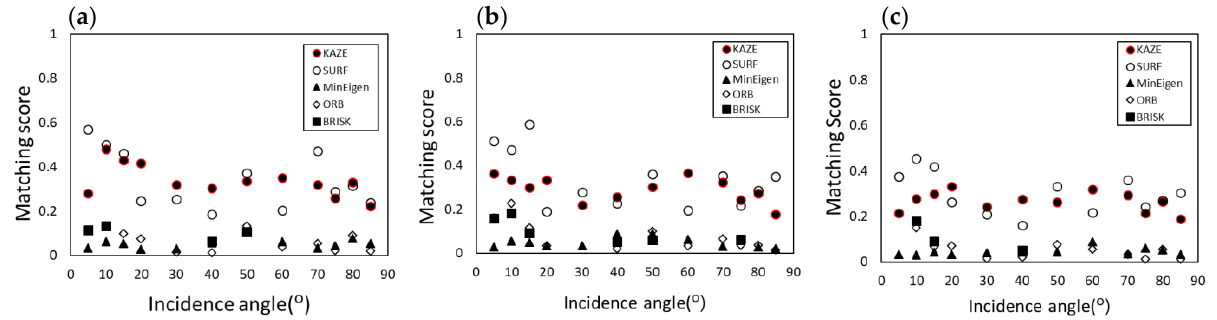
Figure 4. Matching scores of five feature matching methods. ( a ) Facing displacement; ( b ) Settlement; ( c ) Combined displacement.